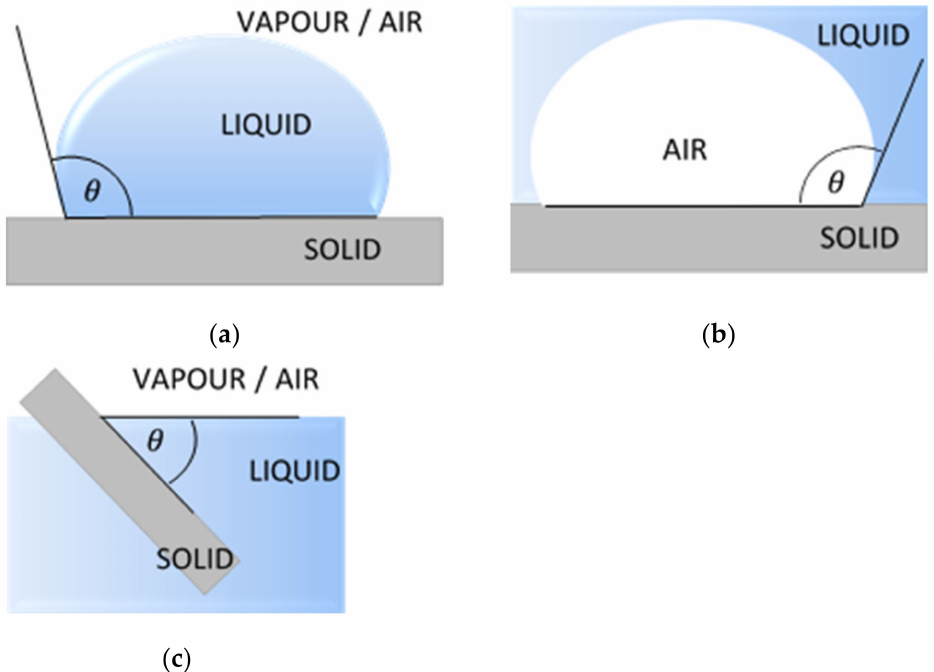
Figure 1. Common methods of the contact angle measurements: ( a ) sessile drop; ( b ) captive bubble; ( c ) tilting plate. θ is a contact